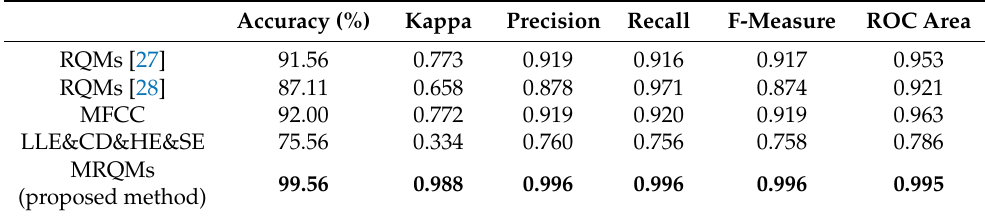
Table 6. Summary of selected studies conducted for detection of pathological voice in MEEI database with 10-fold cross-validation.